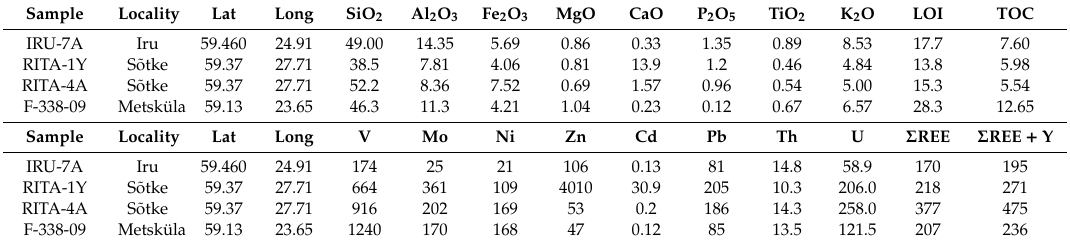
Table 1. Major and trace elements of representative graptolite argillite samples. LOI—Loss on ignition. TOC—total organic carbon. Locations are indicated in Figure 1. Data: Geological Survey of Estonia.